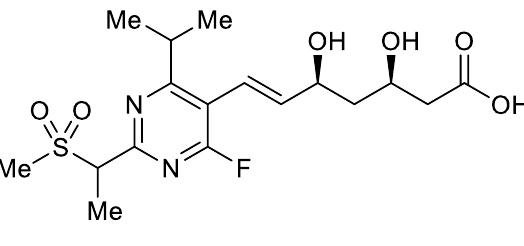
Figure 3. Structure of rosuvastatin.